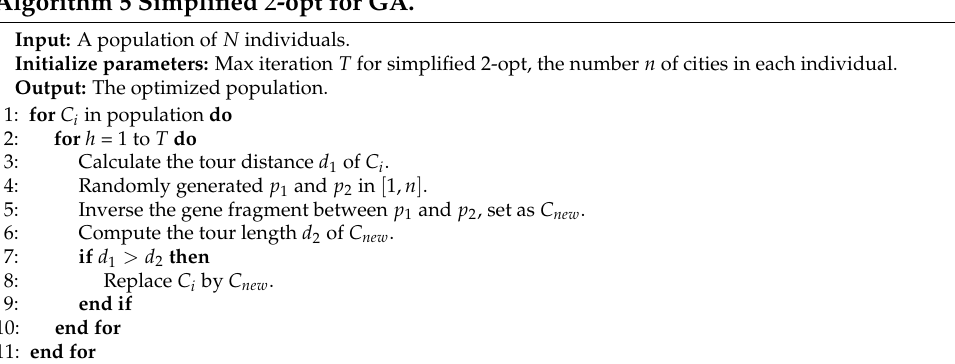
Algorithm 5 Simplified 2 -opt for GA.